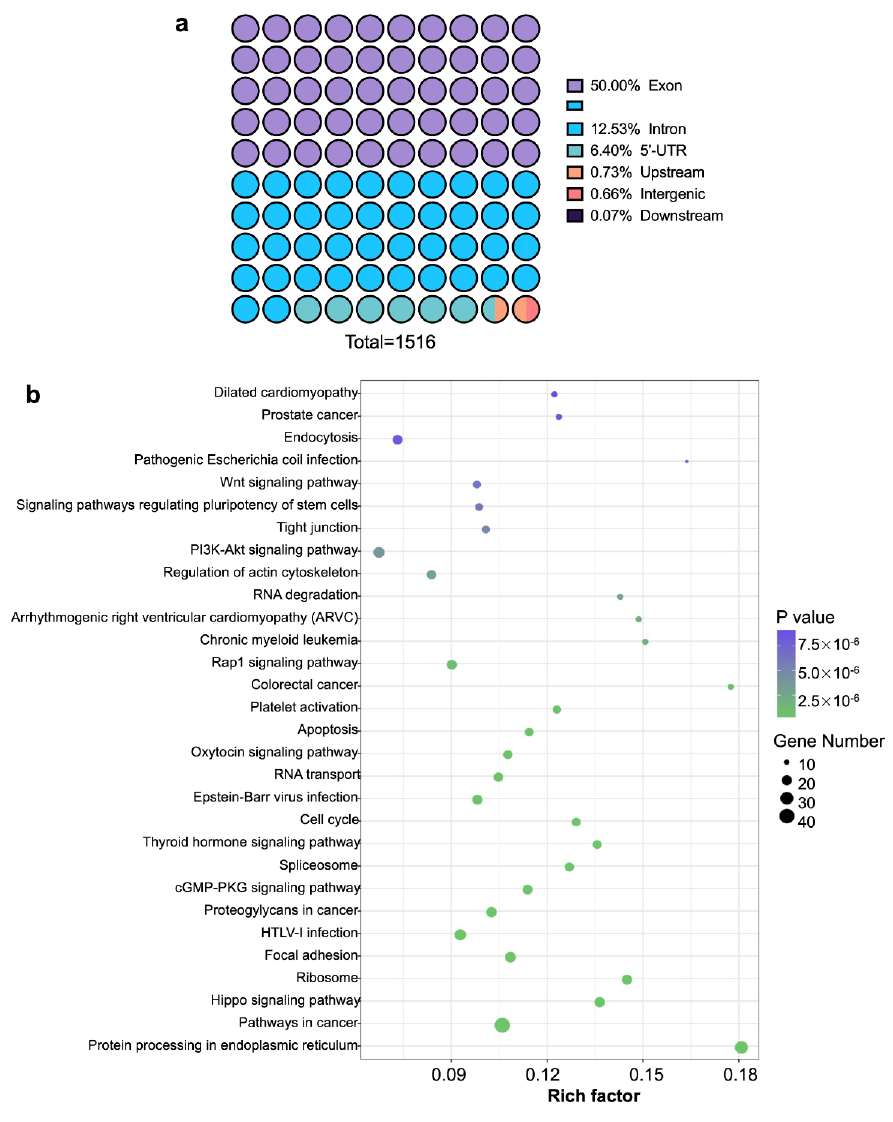
Figure 1. RIP-seq analyses of detecting AUF1’s function in Hela cells. ( a ) Statistics of AUF’s nuclear localization annotation results. Binding peaks were annotated by Homer software, and annotation results were counted. ( b ) KEGG pathway enrichment of AUF1 target genes. The X -axis shows the Rich Factor (the ratio of the number of target genes enriched in this pathway to the number of an- notated genes), and the left Y -axis shows pathways’ names of target genes. The range of p -value is (0,1]. The experiments were parallelly repeated in